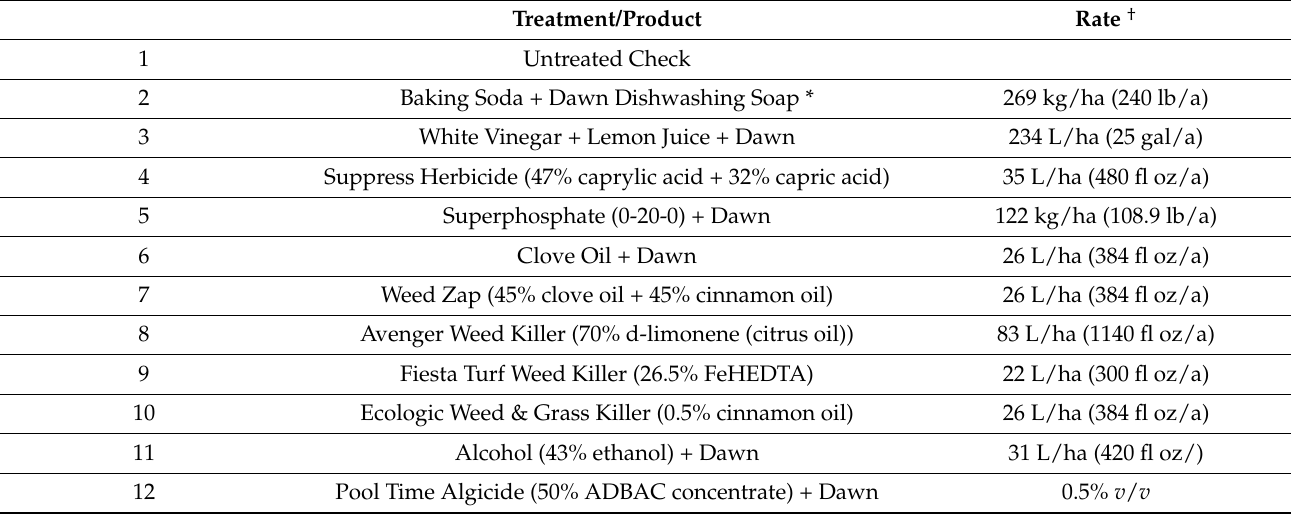
Figure 1. Study plots on TifEagle bermudagrass putting green taken one week after treatment applications. Table 1. Treatments using common products for postemergence Poa annua control.